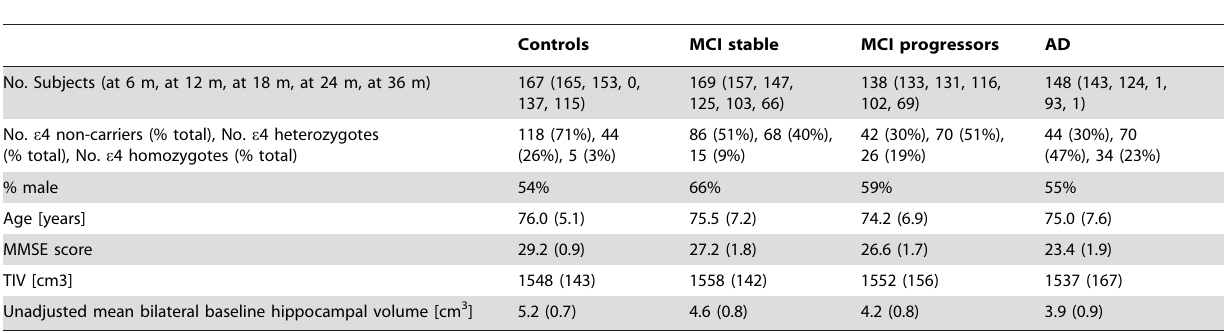
Table 1. Baseline demographics and image summary statistics by clinical group.